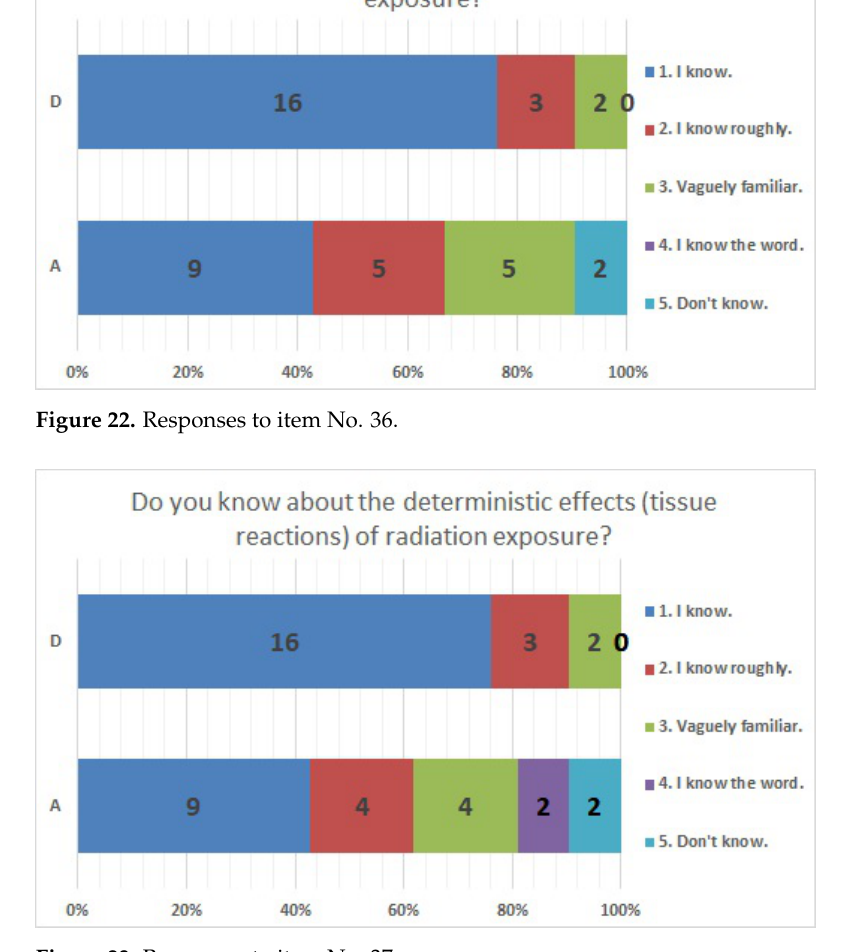
Figure 23. Responses to item No.